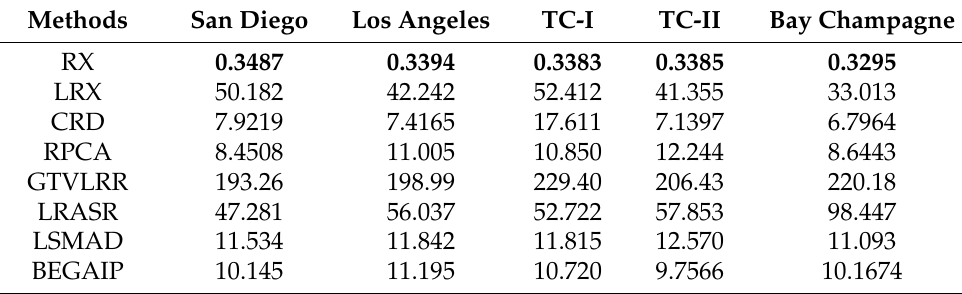
Table 5. Average time cost (second) of all the algorithms on the data sets.